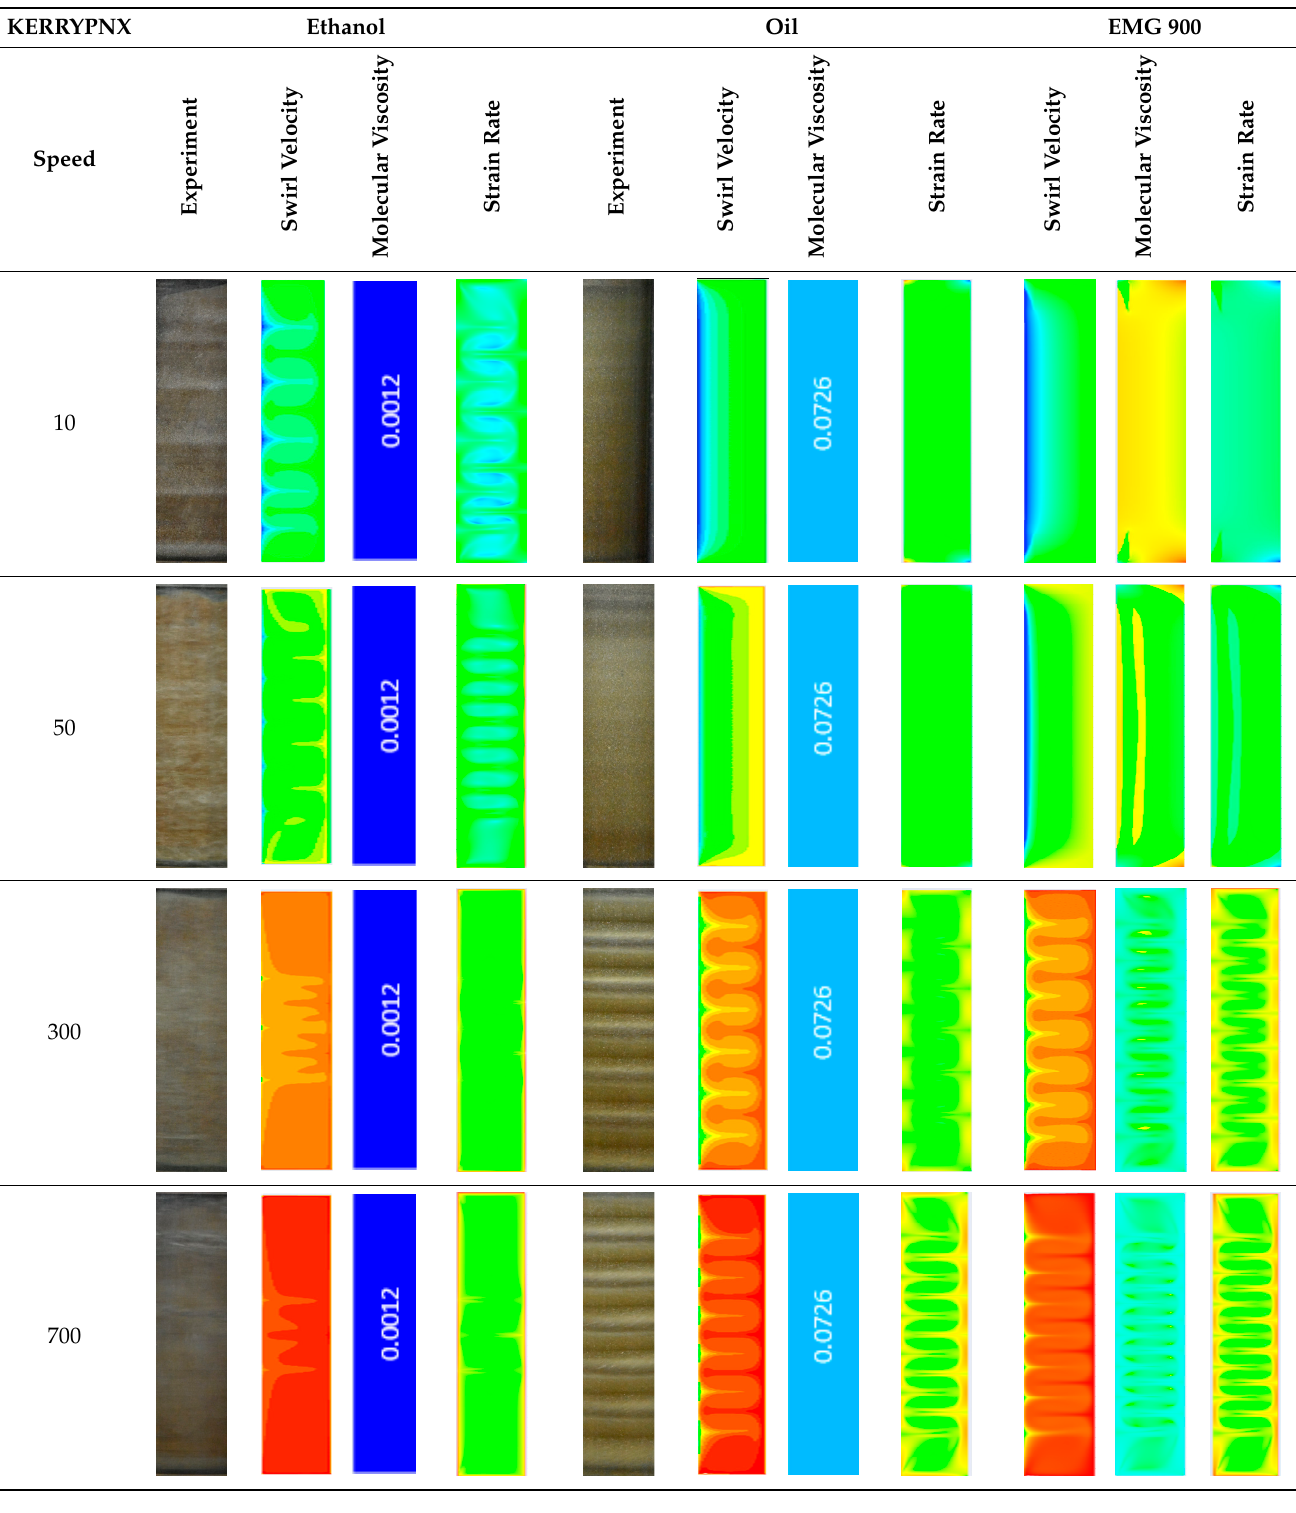
Table 4. Speed-dependent flow simulation and comparison with the experiment.